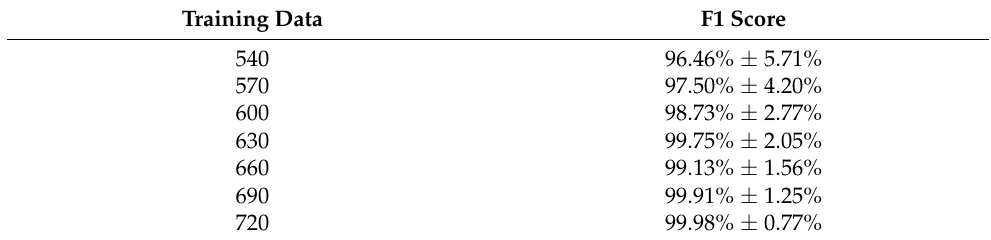
Figure 4. Average and standard deviation of F1 scores of the proposed method for age group recognition under different numbers of training data. Table 4. Performance of the proposed method for age groups recognition as the size of training data